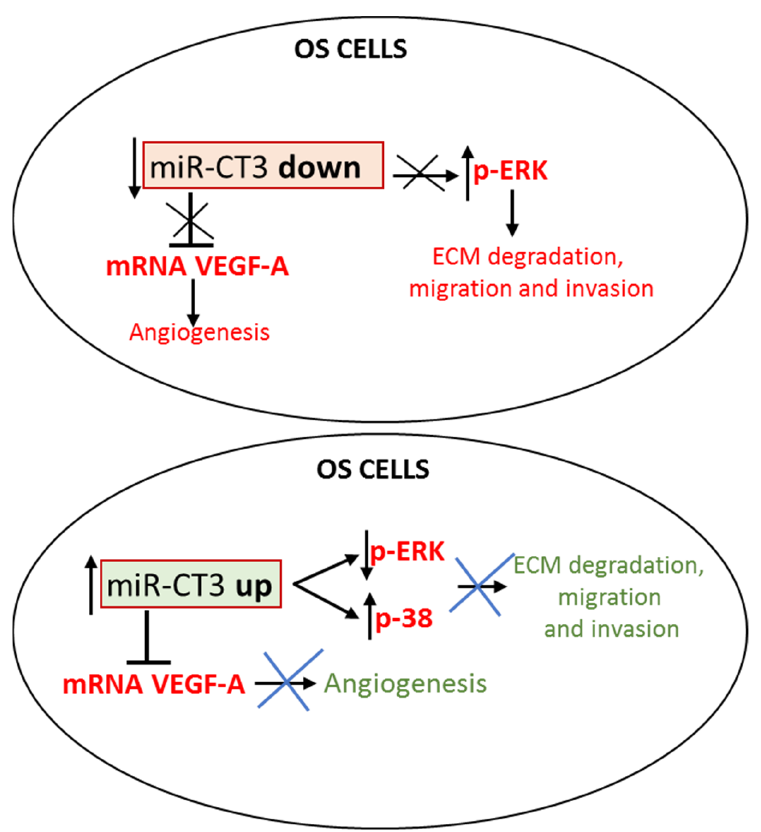
Figure 8. MiR-CT3 controls invasiveness in OS cells. Upper Figure: miR-CT3 expression is maintained low in OS cells thus allowing the expression of pro-angiogenic factors and the mechanisms of cellular invasion/migration. Lower Figure: when miR-CT3 expression is over-expressed, it can (1) binds and blocks the expression of mRNA VEGF-A, thus reducing tumor angiogenesis and (2) inhibits the phosphorylation of pERK1/2, activates the phosphorylation of p38 MAPK and controls the EMT-proteins expression, thus perturbating the mechanisms of cellular